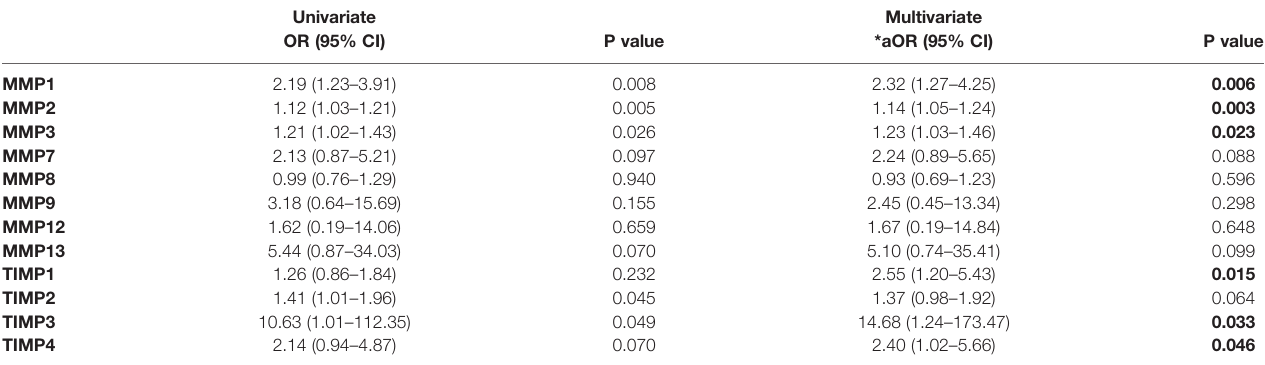
*Multivariate model was adjusted for age, sex and culture status. Bold values indicates the signi fi